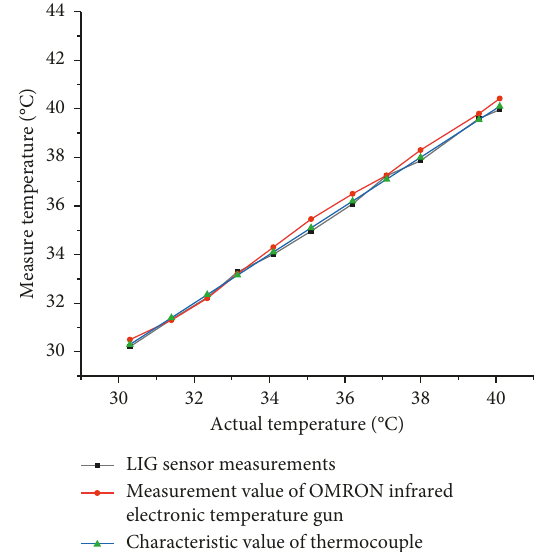
Figure 7: Comparison test results of LIG sensor